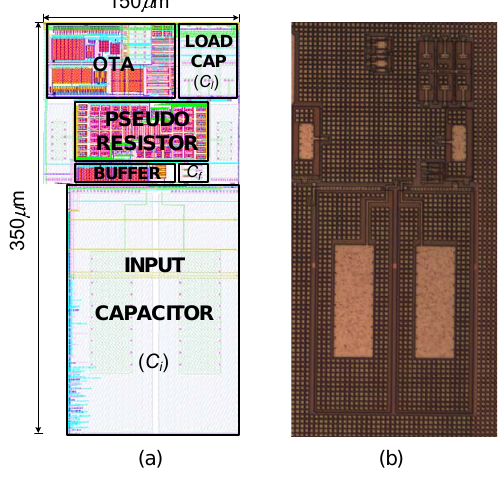
Figure 11. LNA implementation: ( a ) layout; ( b ) microphotograph.